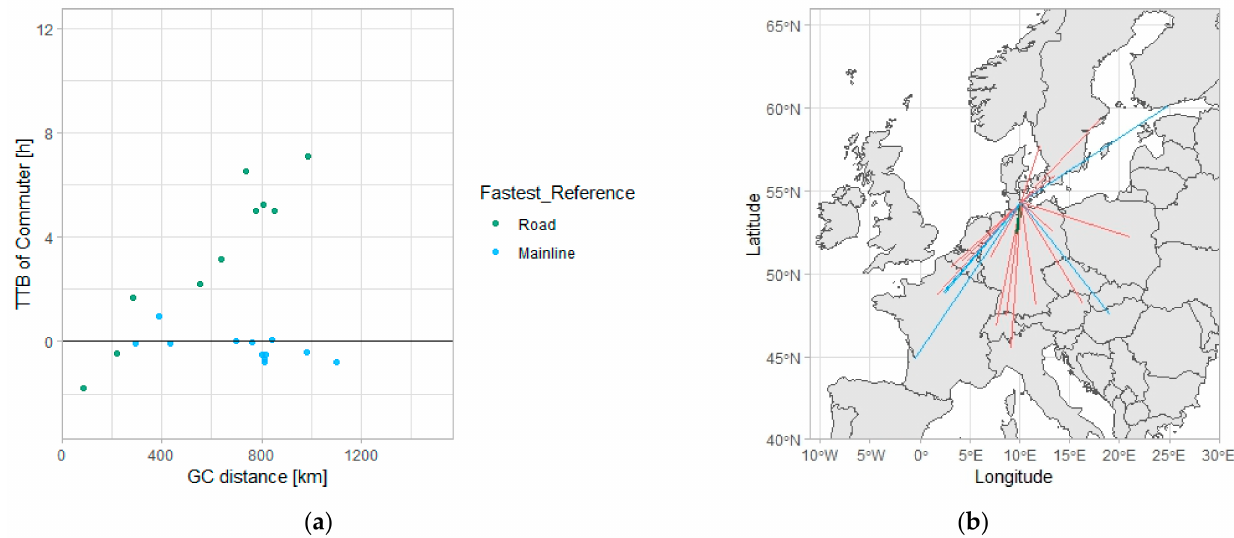
Figure 2. Results of the travel time benefit analysis for the exemplary region, Kiel, in Germany: ( a ) travel time benefit of commuter air services in regard to the fastest reference mode of transportation, and ( b ) map illustrating the identified connections with the shortest travel times by road green), commuter (red), and airline